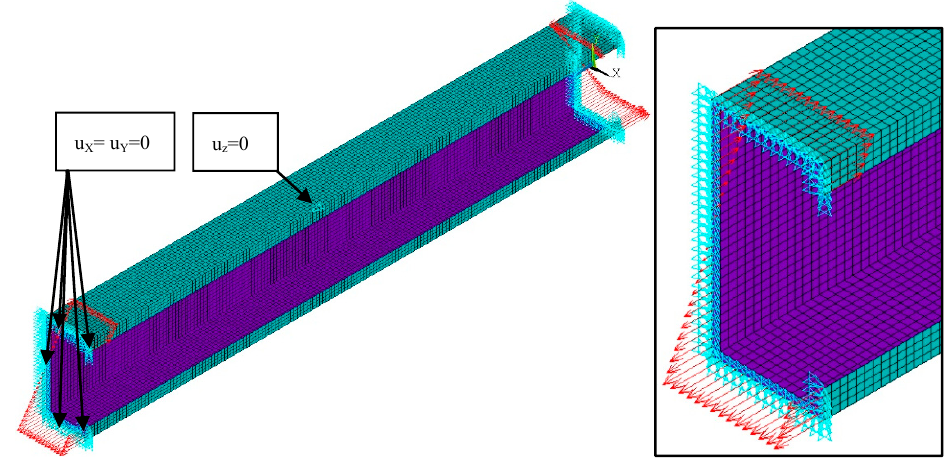
Figure 1. Discretized numerical model with applied type I boundary conditions.